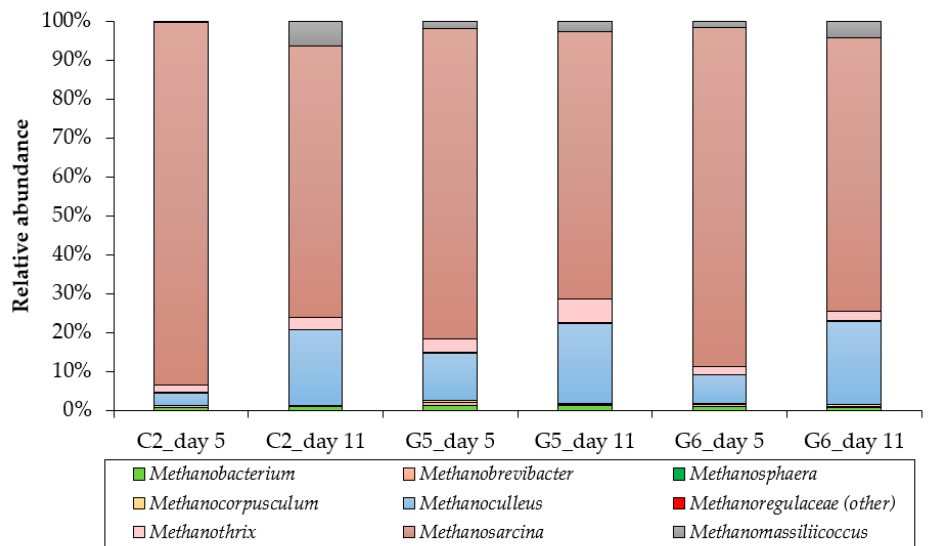
Figure 7. Taxonomic composition of the methanogenic communities in reactors C2, G5, and G6 (sampled on days 5 and 11). Methanogenic community composition according to amplicon sequencing of the archaeal 16S rRNA gene is shown on the genus level.